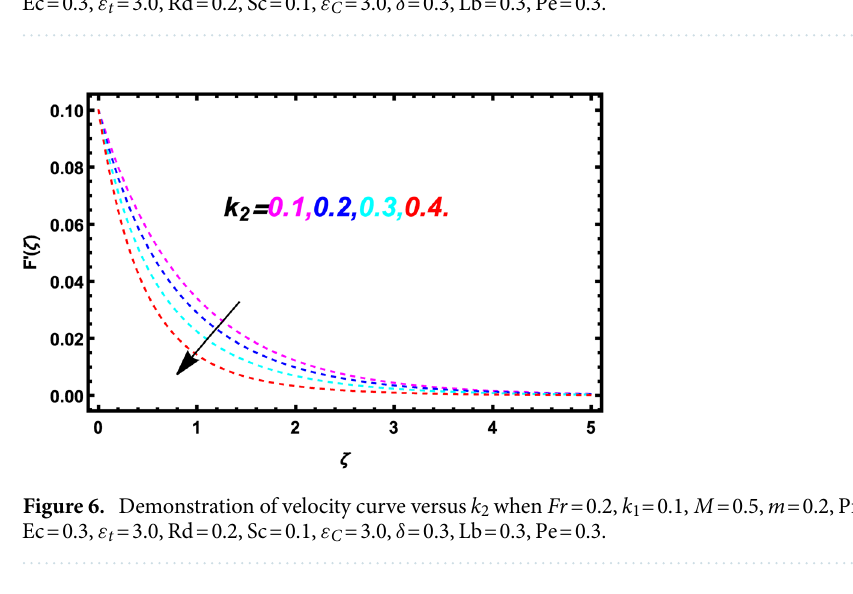
Figure 5. Demonstration of velocity curve versus k 1 when Fr = 0.2, k 2 = 0.3, M = 0.5, m = 0.2, Pr = 5.3, φ = 0.01, Ec = 0.3, ε Rd = 0.2, Sc = 0.1, ε Lb = 0.3, Pe = 0.3. t = 3.0, C = 3.0, δ = 0.3,